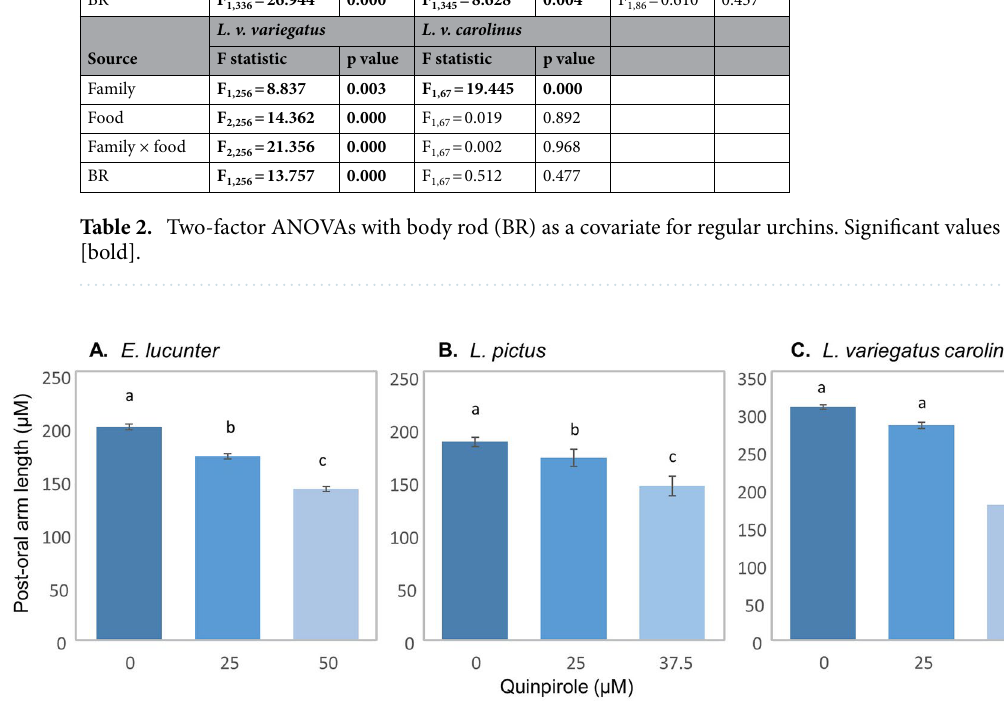
Figure 3. Regular urchins without phenotypic plasticity retain the phenotypic response to dopamine receptor activation. Change in post-oral arm length at initiation of feeding with treatment of the dopamine type-2 receptor agonist, Quinpirole, at varying concentrations for the three regular urchins, E. lucunter ( A F 2,348 = 124.996, p < 0.001), L. pictus ( B F 2,96 = 38.662, p < 0.001), and L. variegatus carolinus ( C F 2,100 = 290.433, p < 0.001) lacking a phenotypic response to food (Fig. 2). Error bars, ± standard error of the mean. Letters denote significant post-hoc Bonferroni comparisons between Quinpirole treatments, p <